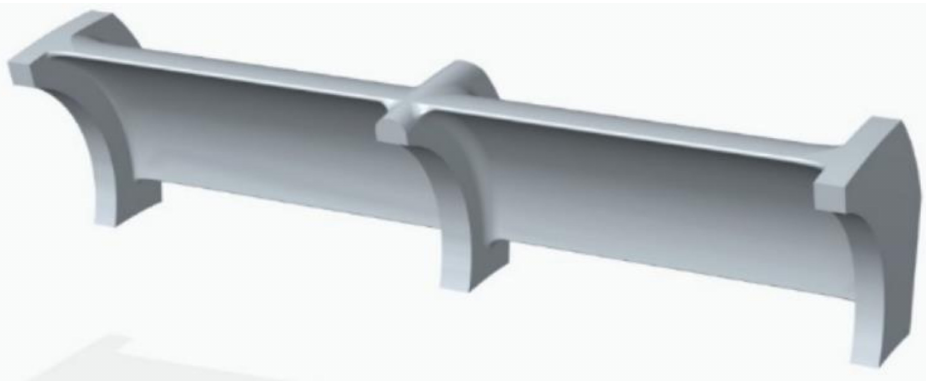
Figure 14. Final CAD model including part of the disks and the